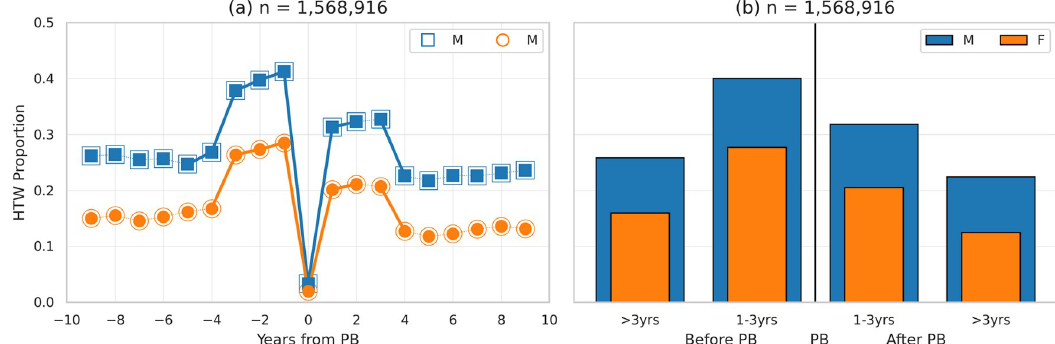
Fig 3. The proportion of male and female runners hitting the wall based on the number of years before ( < 0) and after ( > 0) achieving their overall (estimated) PB: (a) shows the relevant proportions of runners hitting the wall for each year before and after a PB; (b) shows the aggregate proportion of runners hitting the wall during four periods, 4–9 years before/after a PB and 1–3 years before/after a